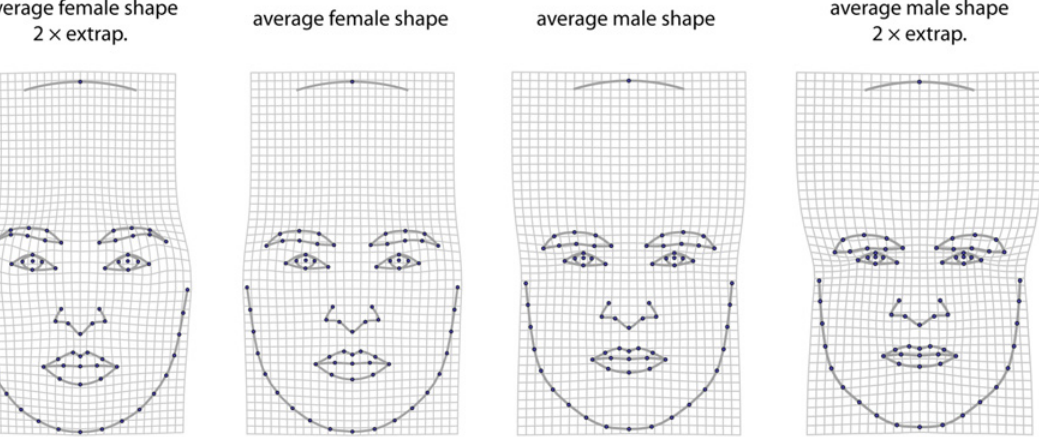
Fig 4. Sexual dimorphism is visualized by deformation grids between average female and average male facial shape, together with two-fold extrapolations of these shape differences.